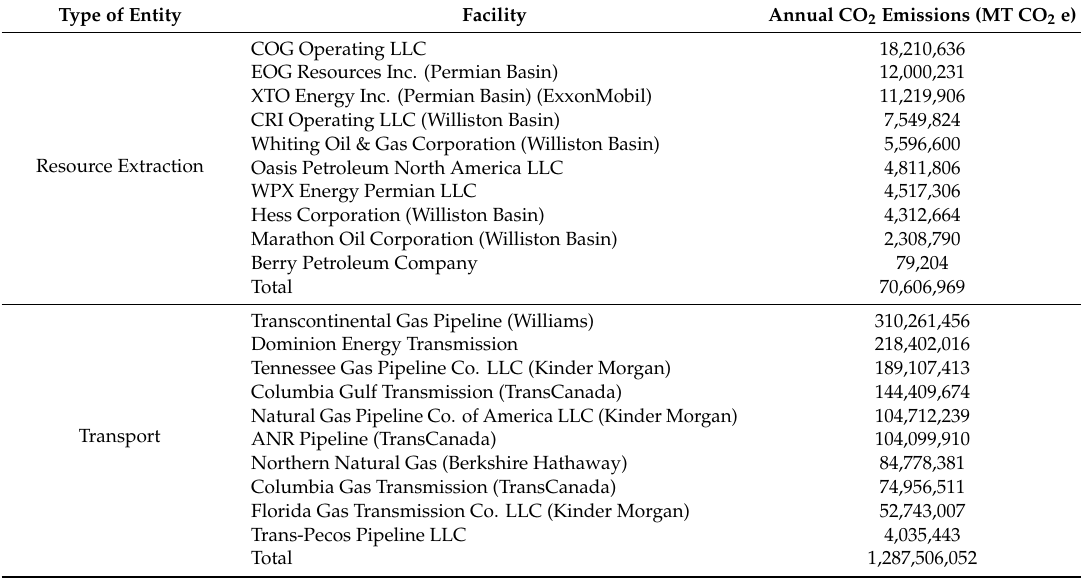
Table A7. Top CO 2 Bottlenecks of the Natural Gas Industry for Resource Extraction, Transport, and